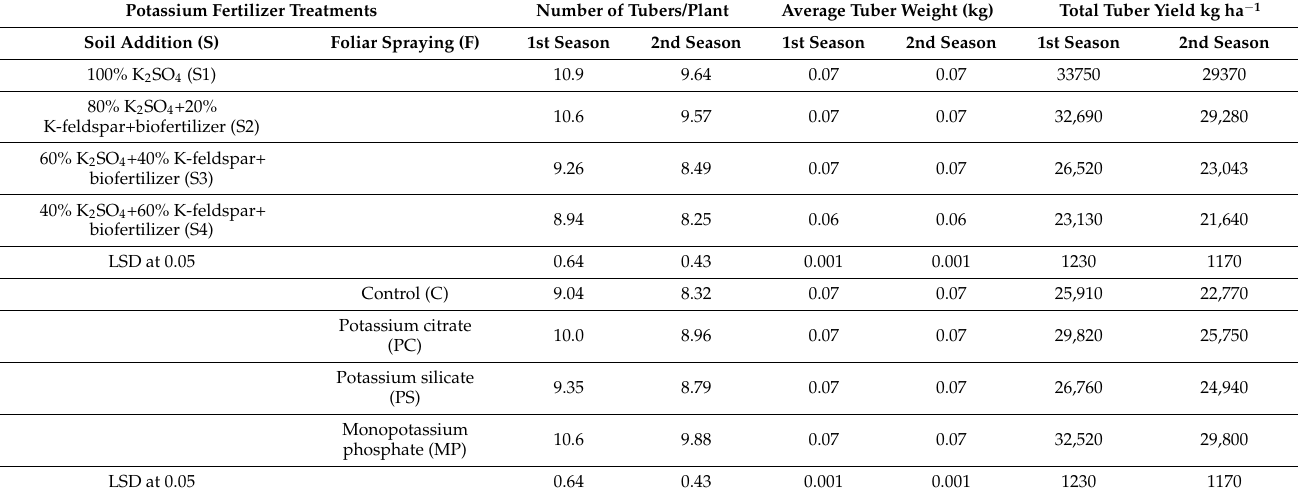
Table 5. The effect of potassium fertilization with soil addition (S) or foliar spraying (F) on the yield parameters of potato tubers during the 2018 and 2019 growing seasons. Potassium Fertilizer